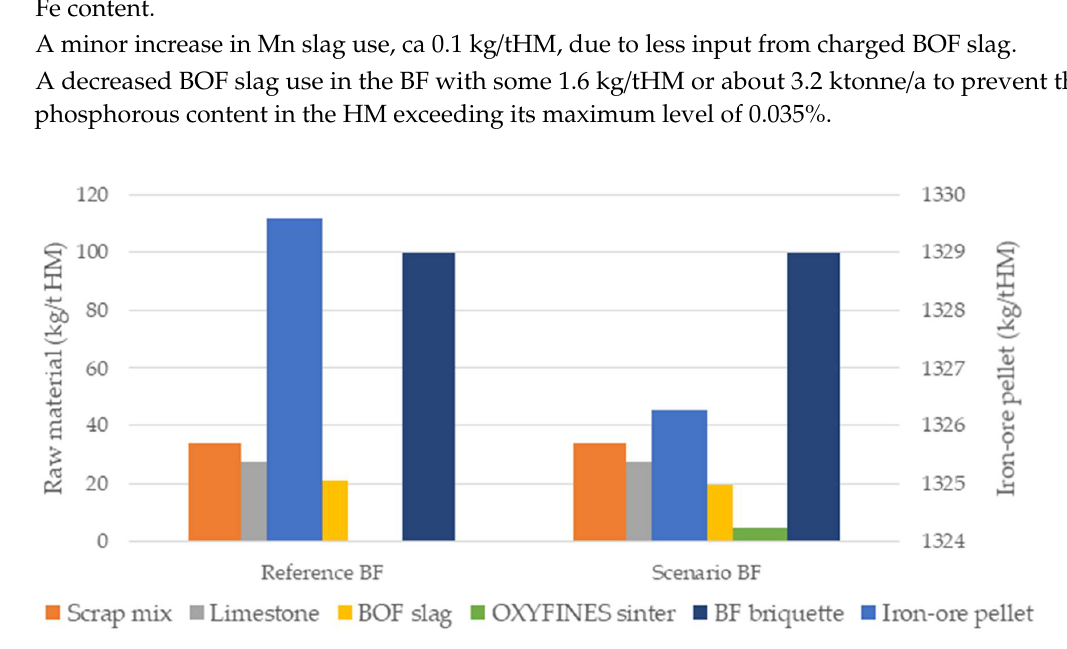
Figure 3. Results on charged BOF raw materials (kg/tLS) from using the OXYFINES sinter.